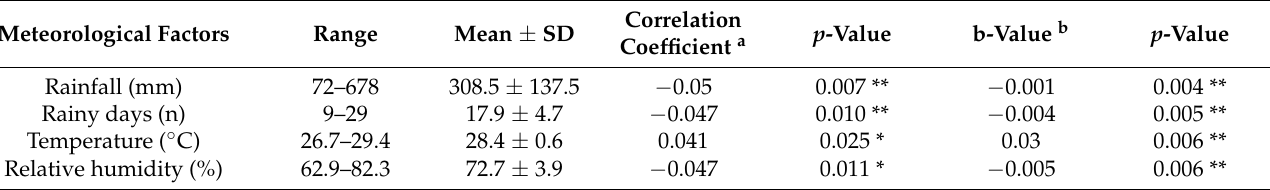
Table 2. Correlation of meteorological factors with RSV